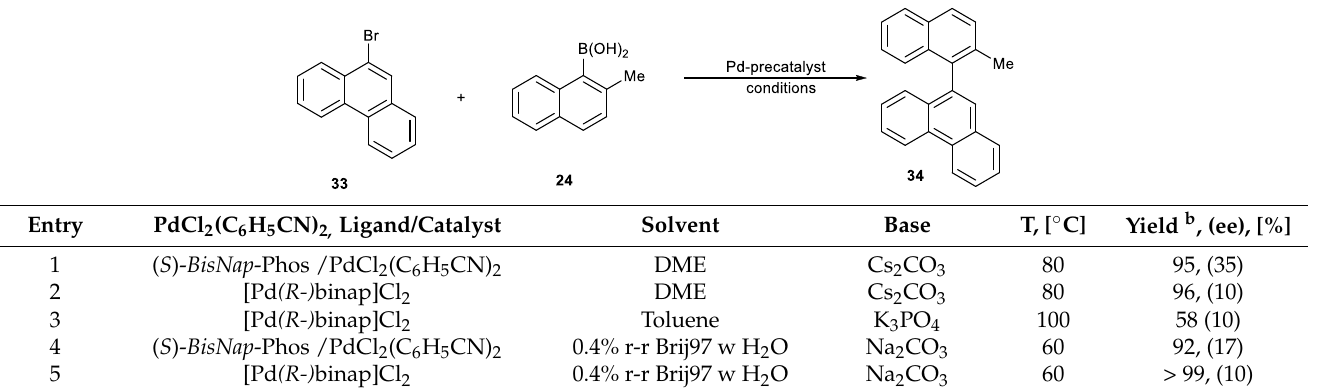
Table 16. Ligand activity in asymmetric synthesis of 34 a .